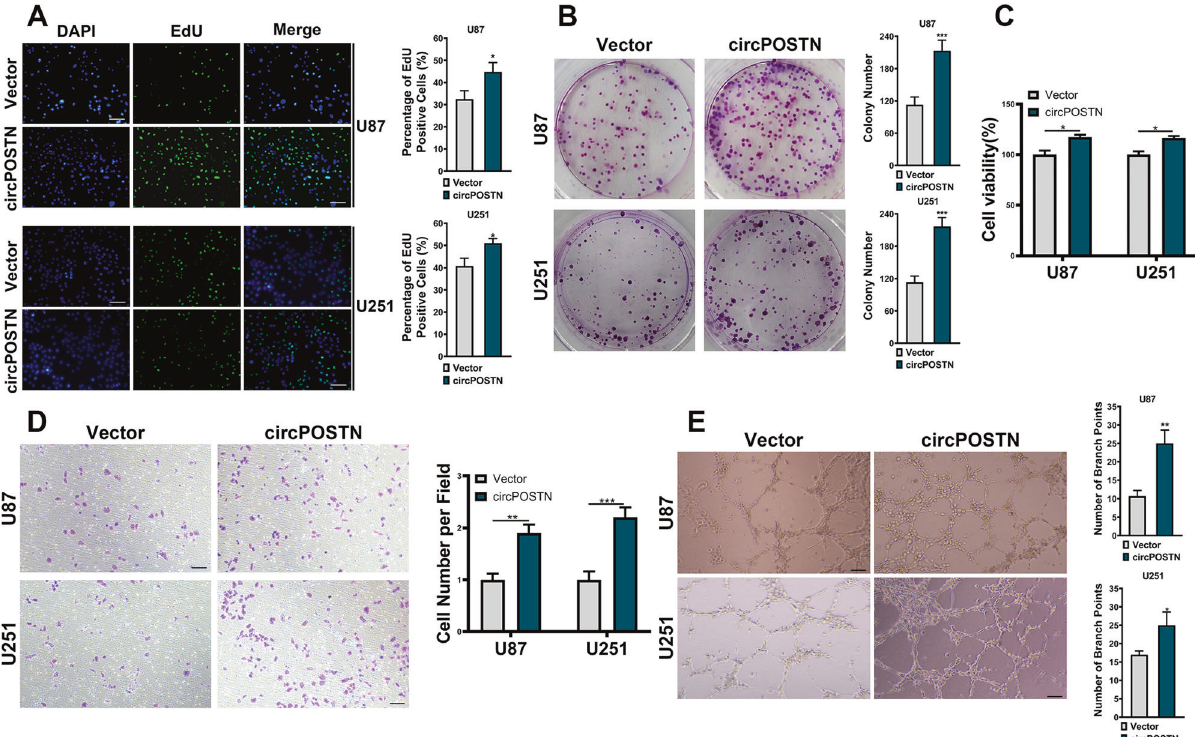
Fig. 2 Upregulation of circPOSTN improves GBM cell proliferation, migration, and tumor angiogenesis in vitro. A Cell proliferation ability of GBM cells with or without circPOSTN overexpressing was determined by EdU staining (green). The Edu-positive cells were recorded and quanti fi ed. The nuclei were stained with DAPI (blue). B The clone formation assay was used to assess the clone formation capacity of GBM cells with or without circPOSTN overexpressing. C – E The human umbilical vein endothelial cells (HUVECs) were cultured with conditioned media from GBM cells with or without circPOSTN overexpressing. C The viability of HUVEC was evaluated by MTT assay. D The transwell migration assay was used to evaluate the migration ability of HUVECs. E The tubule formation assay was used to assess the angiogenesis ability of GBM cells. The tubule formation ability of HUVEC was analyzed by measuring the branch points and tubule number. Data are presented as the mean ± SD. * P < 0.05, ** P < 0.01, *** P <